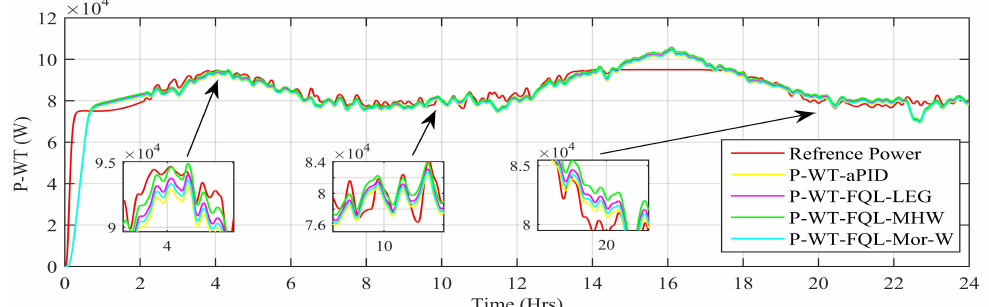
Figure 19. Maximum power point tracking of wind turbine